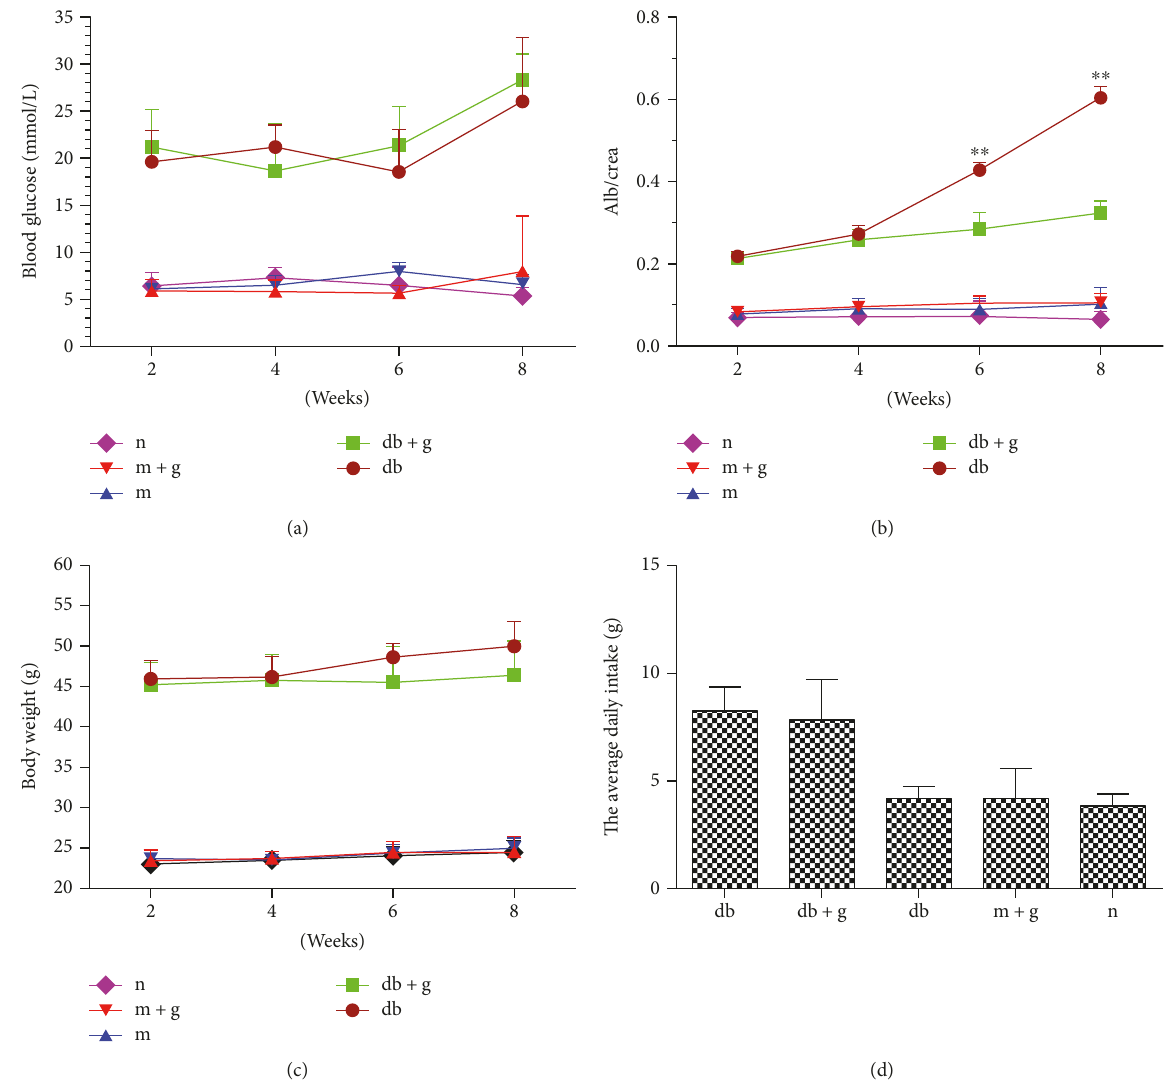
Figure 1: E ff ectofGA ontheonsetofDNindb/dbmice.Treatment withGAdidnot signi fi cantlyalterblood glucoselevels(a),bodyweight(c), or food intake (d) in db/db mice. Alb/crea levels were signi fi cantly lower in the db+ g group than in the db group ( ∗∗ p < 0 05 versus db+